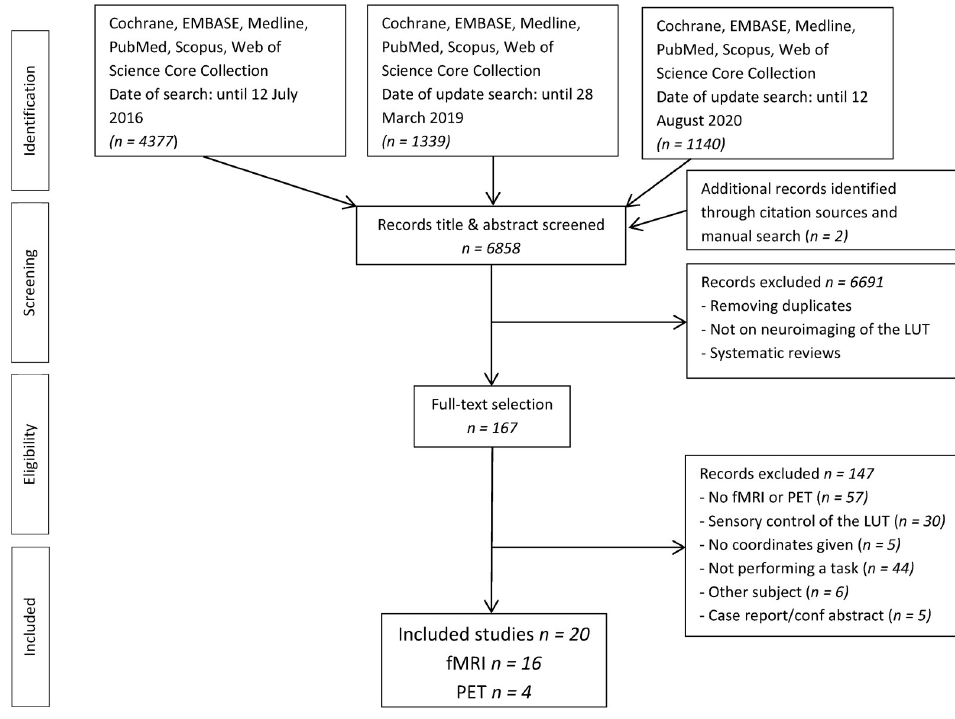
Fig 1. The PRISMA flow